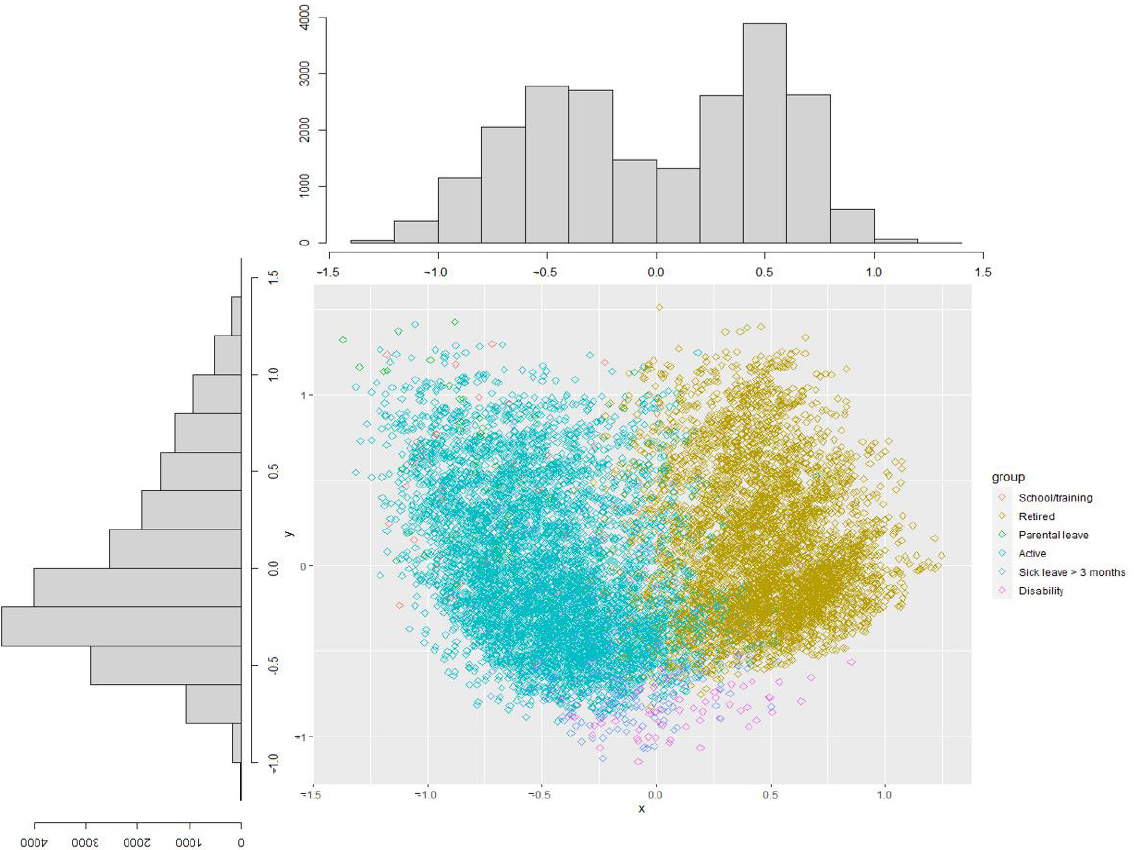
Figure 2. Projection of the distribution of the modalities of occupational status on the respondents’ positions on the two first factorial axis.